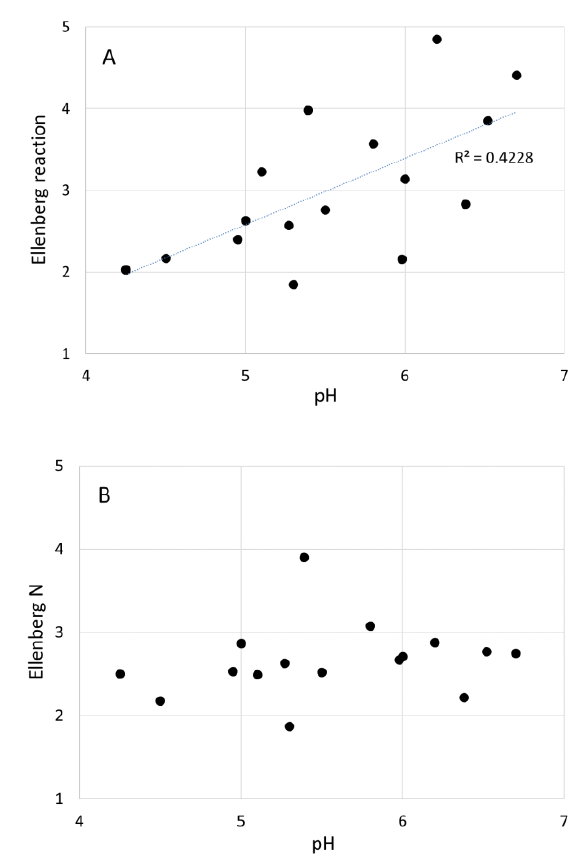
Figure 2. The relationships of the Ellenberg indicator values for (A) reaction and (B) nitrogen with measured pH values.